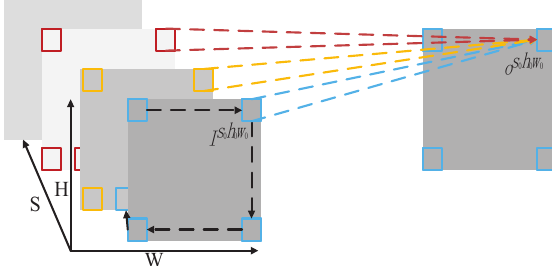
Figure 2. Illustration of a 3D convolution operation. The convolution kernels slide along both the spatial and spectral dimensions of the input 3D images and generate the 3D spectral–spatial features.